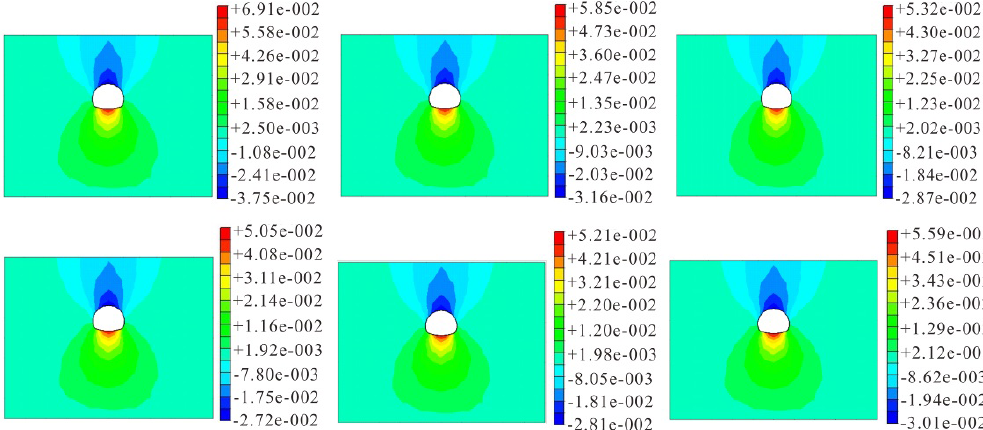
Figure 9. Vertical displacement of the vault under working Conditions 1–6 (mm).